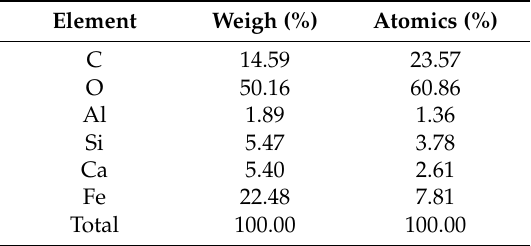
Figure 4. EDS pattern of Fe-C material. Table 2. Elemental analysis of Fe-C material.